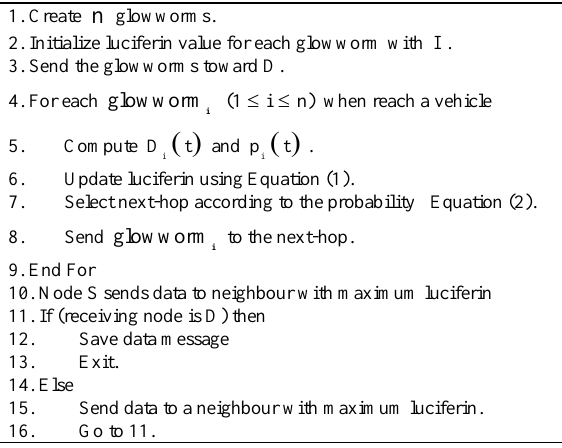
Figure 3. Pseudo-code of proposed